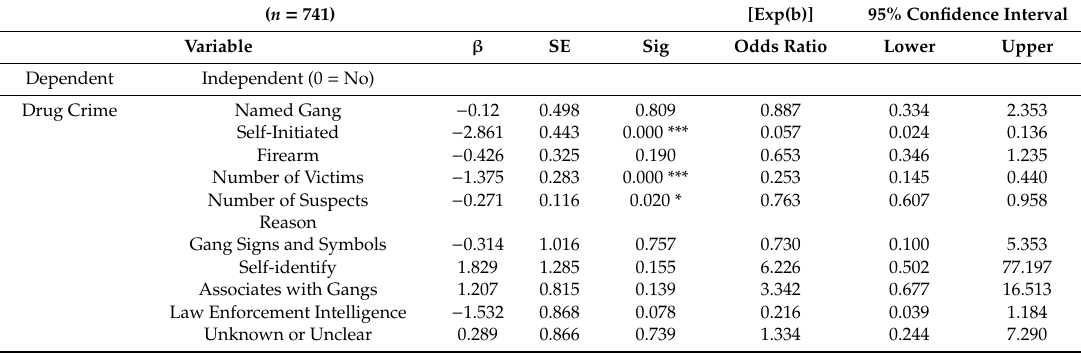
Table 4. Multinomial logistic regression for drug crimes compared with violent